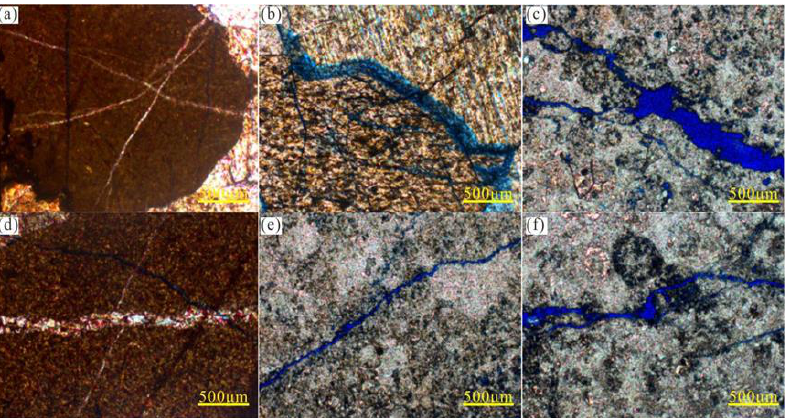
Figure 2. Fracture characteristics of Ordovician and Cambrian carbonate rocks. ( a ) Micritic limestone (well NP1-90, 5224.80 m); ( b ) silty limestone (well NP1-90, 5224.80 m); ( c ) dolomite (well NP3-80, 5682.59 m); ( d ) dolomite (well NP3-80, 5224.80 m); ( e ) micritic limestone (well NP1-90, 5682.59 m); and ( f ) dolomite (Well NP3-80, 5682.59 m). The advantage of cast thin sections over conventional thin sections is that the pore space is filled with stained resin or liquid glue, and the pore space can be directly and conveniently observed by a polarizing microscope while avoiding artificially induced pores and cracks.